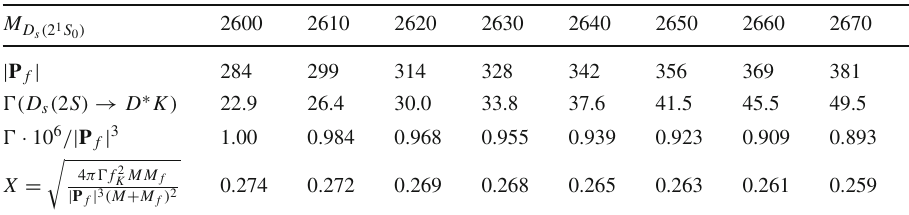
decay width (cid:3) (MeV), ratio (cid:3) · 10 6 / | P | 3 (MeV − 2 ) and f quantity X on the variation of the D s ( 2 S ) mass (MeV) or the recoil momentum | P f |